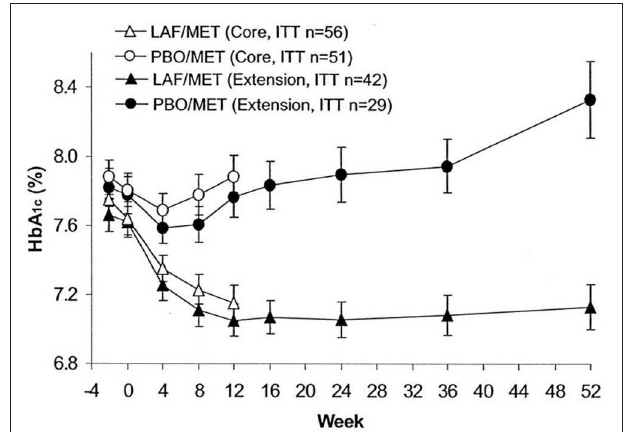
FIGURE 5 | Time course of HbA 1c in a core study (open symbols) and an extension study (closed symbols) in 56 subjects with type 2 diabetes treated with the DPP-4 inhibitor vildagliptin (LAF237) and metformin and 51 subjects treated with placebo and metformin. Forty-two subjects with vildagliptin plus metformin and 29 subjects with placebo plus metformin participated in the extension. Data are means ± S.E.M. Data from Ahrén et al. ( 53). Reprinted with permission from the American Diabetes Association.